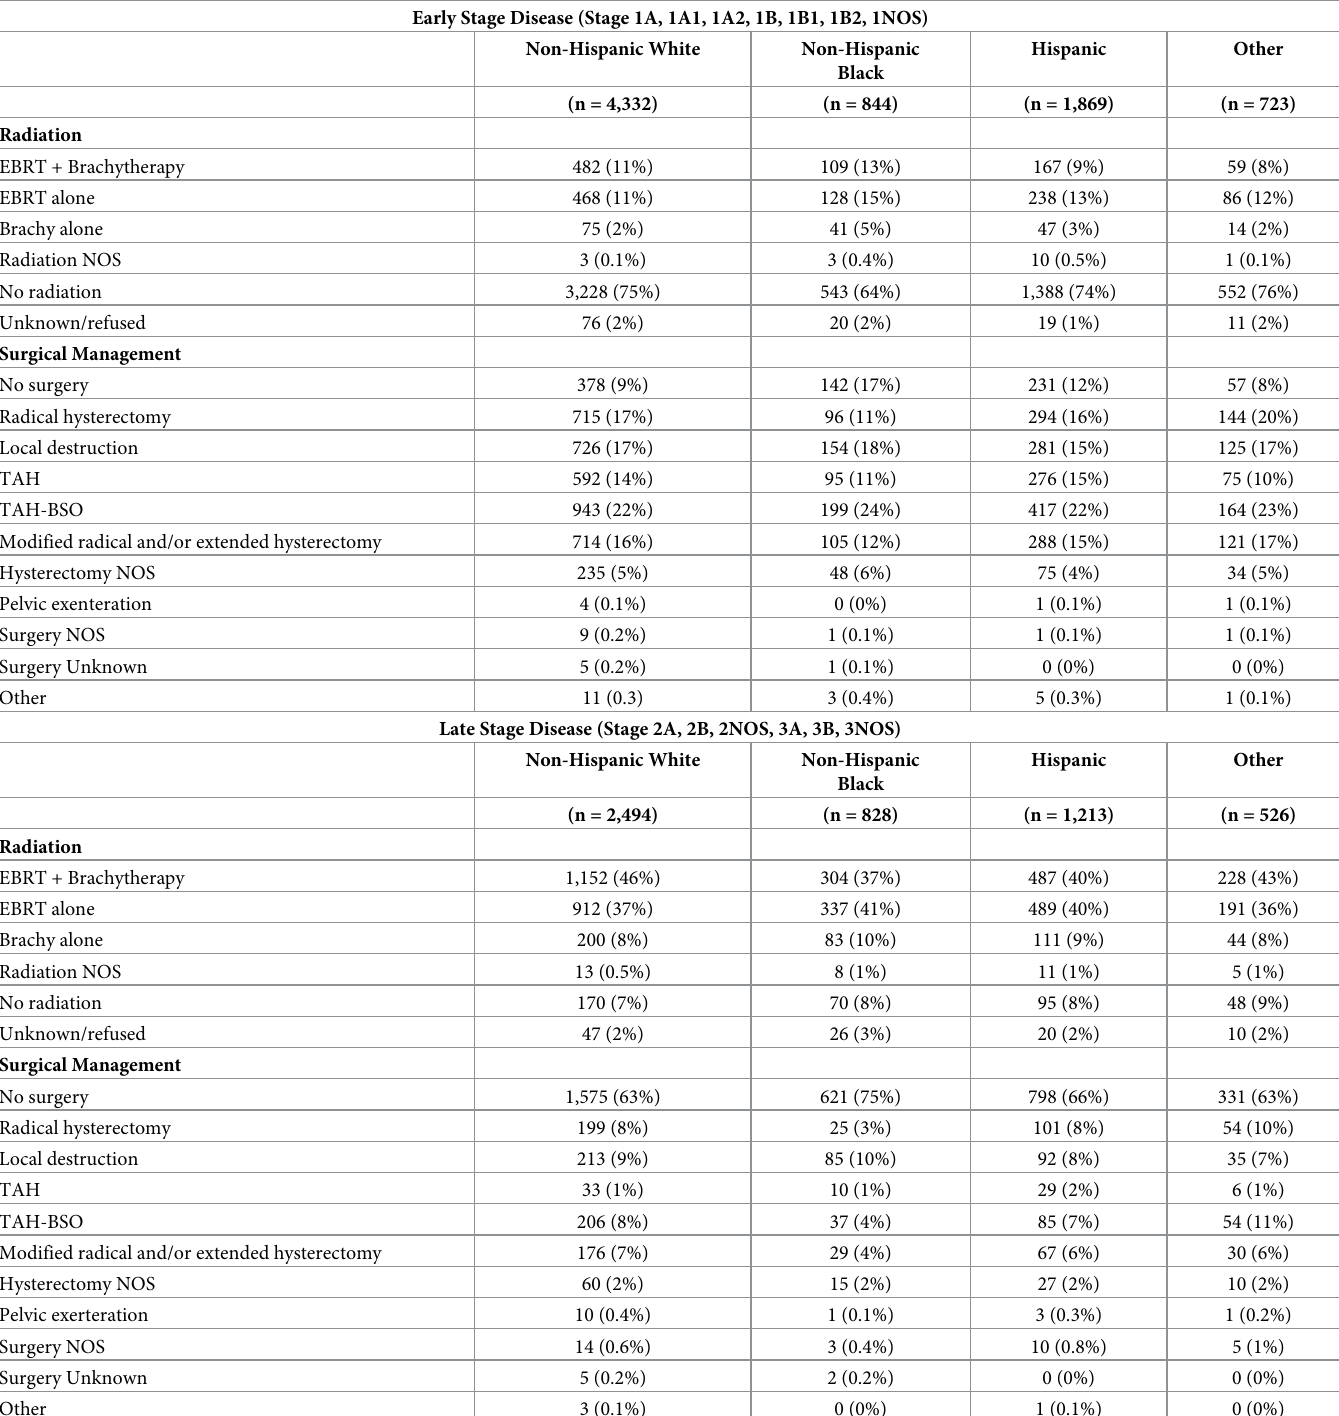
Table 4. Treatment given for cervical cancer by race, stratified by stage of disease at diagnosis. Early Stage Disease (Stage 1A, 1A1, 1A2, 1B, 1B1, 1B2,